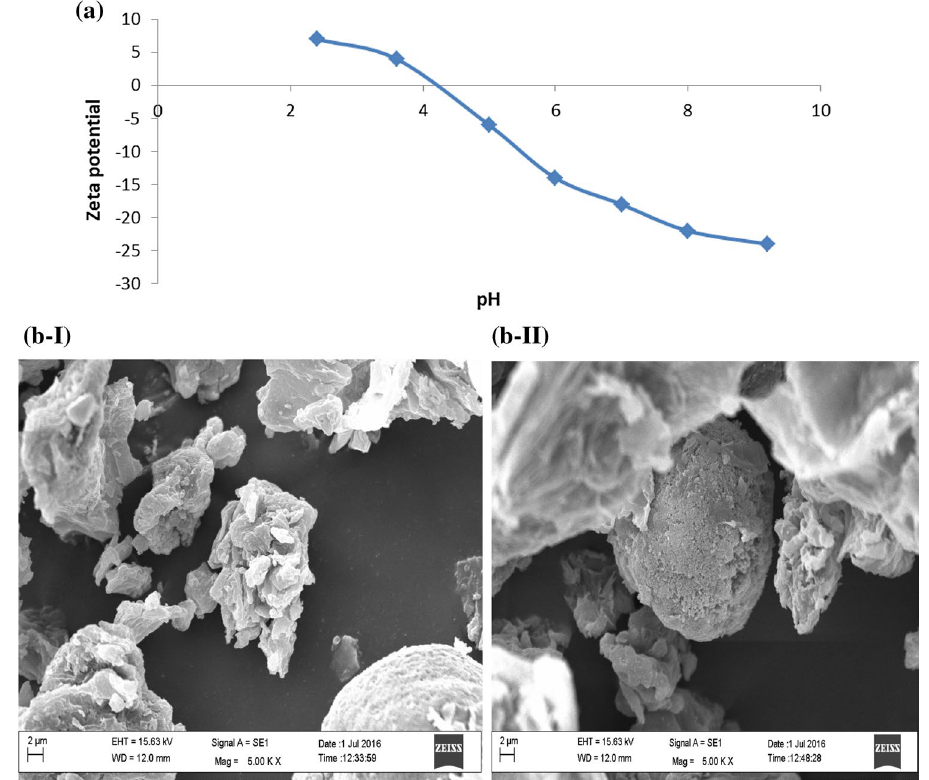
Fig. 1 a pH of zero point charge of ABL and SEM images of ABL b -I before biosorption and b -II after biosorption